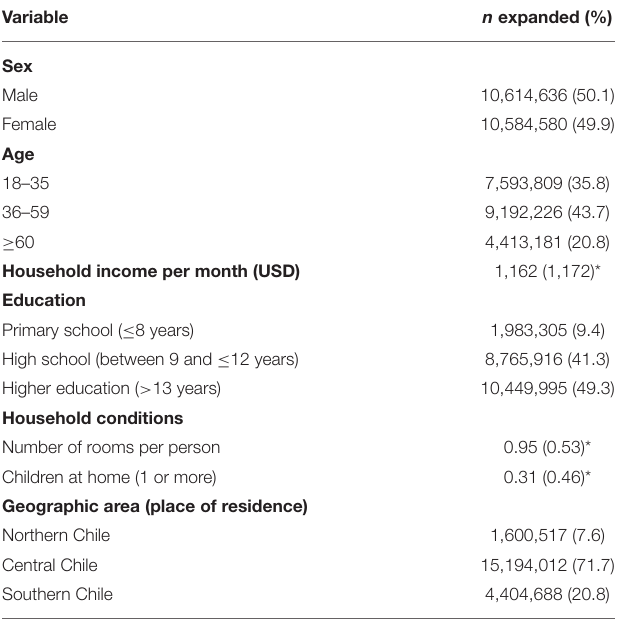
TABLE 1 | Sociodemographic characteristics of the panel sample